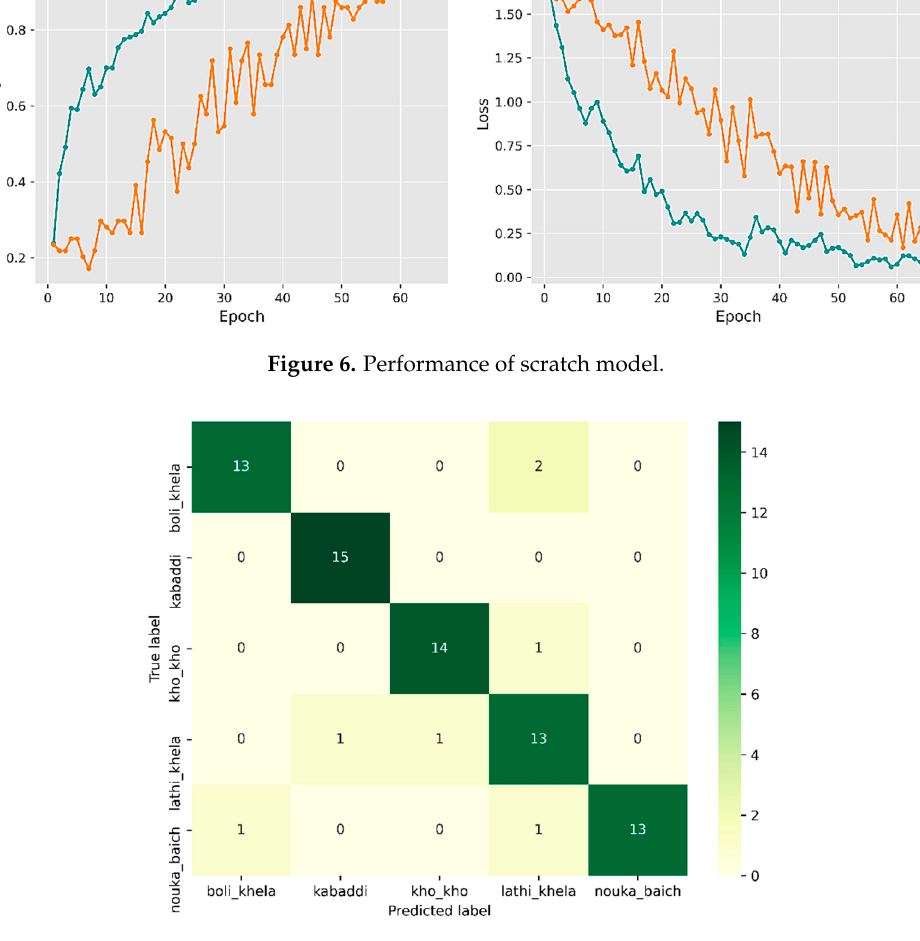
Table 4. Performance comparison of some pretrained models on the TBSV